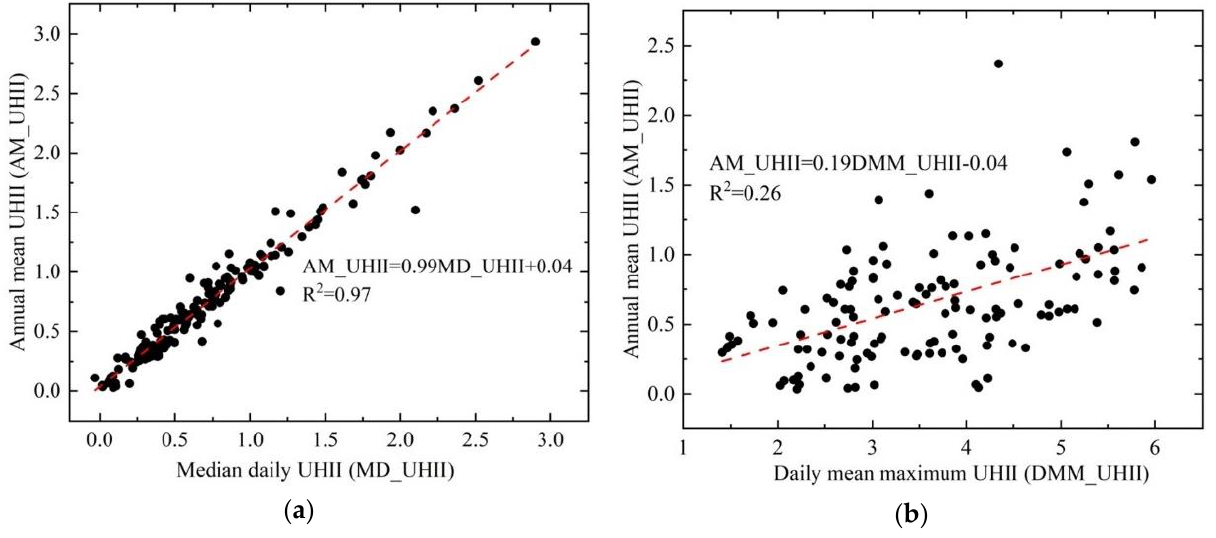
Figure 3. ( a ) The relationship between annual mean UHII and daily mean maximum UHII. ( b ) The relationship between annual mean UHII and median daily UHII.